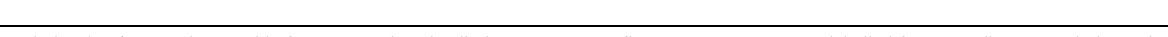
Fig. 6 Microtubules (MT) are indispensable for VEGF-induced cell elongation. a Con fl uent HUVECs immune labelled for VE-cadherin, α -tubulin and Phalloidin-TRITC after VEGF treatment for 24 h or PBS for control, as indicated. Nuclei are stained blue with DAPI. LSM demonstrates MT in control cells evenly distributed throughout the cells, while a few MT are aligned in parallel with JAAF (red arrows). VEGF-induced elongated cells display MT running parallel to the longitudinal cell axis together with stress fi bres, and MT are enriched at the leading edge (white arrows; for dynamics compare supplementary Movie 10) (Scale bar: 20 µ m). The cropped area displays an interrupted VE-cadherin pattern, MT enrichment, and stress fi bres at the cell poles (arrowheads; for dynamics compare Supplementary Movies 10 and 11) (scale bar: 10 µ m). b Con fl uent HUVEC cultures treated with 50 ng ml − 1 nocodazole for 4 h and subsequently labelled with VE-cadherin antibody and with Phallodin-TRITC for actin fi laments. MT depolymerisation had less effect on the JAAF and VE-cadherin distribution (Scale bar: 20 µ m). c – e Con fl uent HUVECs pre-treated with 50 ng ml − 1 nocodazole for 30 min and then